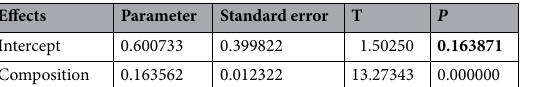
Table 5. Regression analysis for K/S values in terms of nanosilver loading. Bold p values indicate not